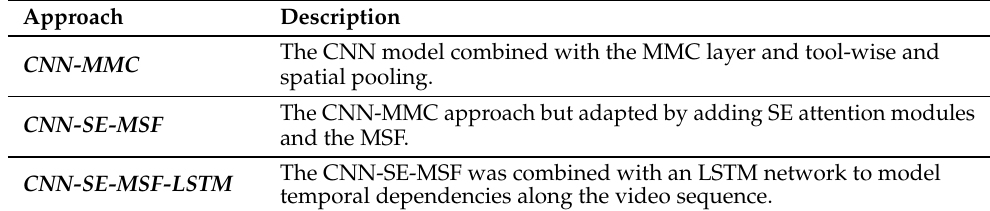
Table 2. Description of the evaluated